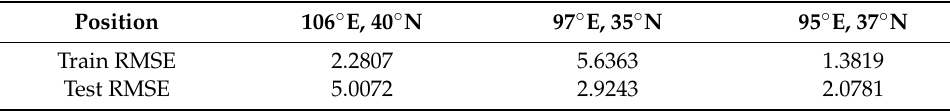
Figure 9. The observation and prediction data using LSTM model of three positions. Table 2. The train RMSE and test RMSE at three